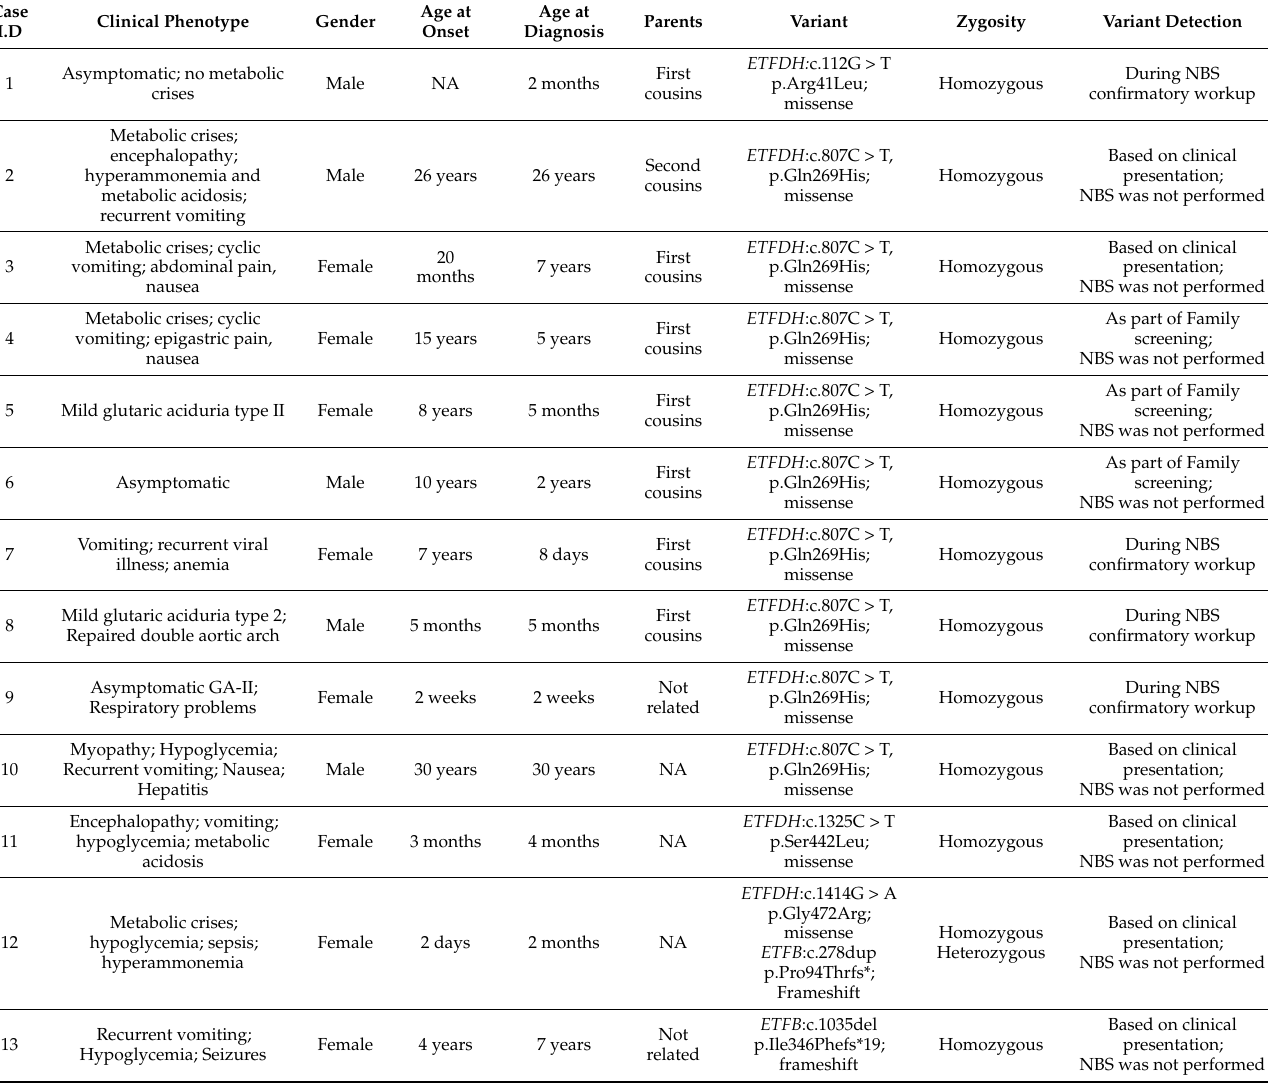
Table 1. Clinical characteristics and genotypes of the studied